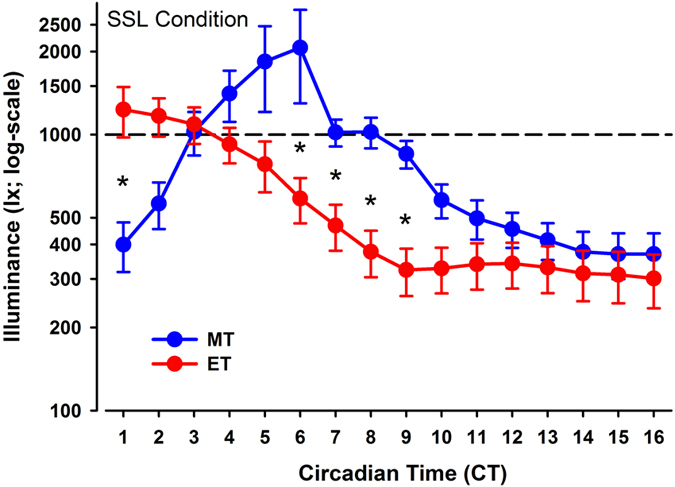
Time course of vertical illuminance (log-scale) for both chronotypes in the self-selected lighting (SSL) condition (means ± SEM).The vertical dashed line indicates the constant bright light condition (=1000 lx). Blue symbols = MT and red symbols = ET. The x-axis indicates circadian time (CT; where CT 0 = wake time); *significant difference between MT and ET (p < 0.05).